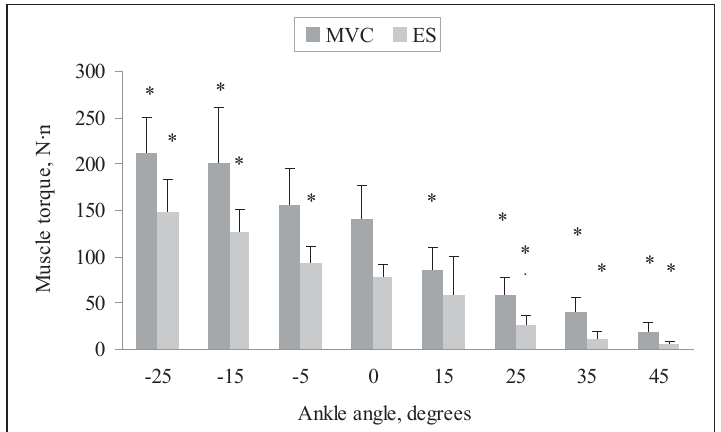
Note. * – p < 0.05, the difference between 0° and –25; –15; –5; 15; 25; 35; 45°